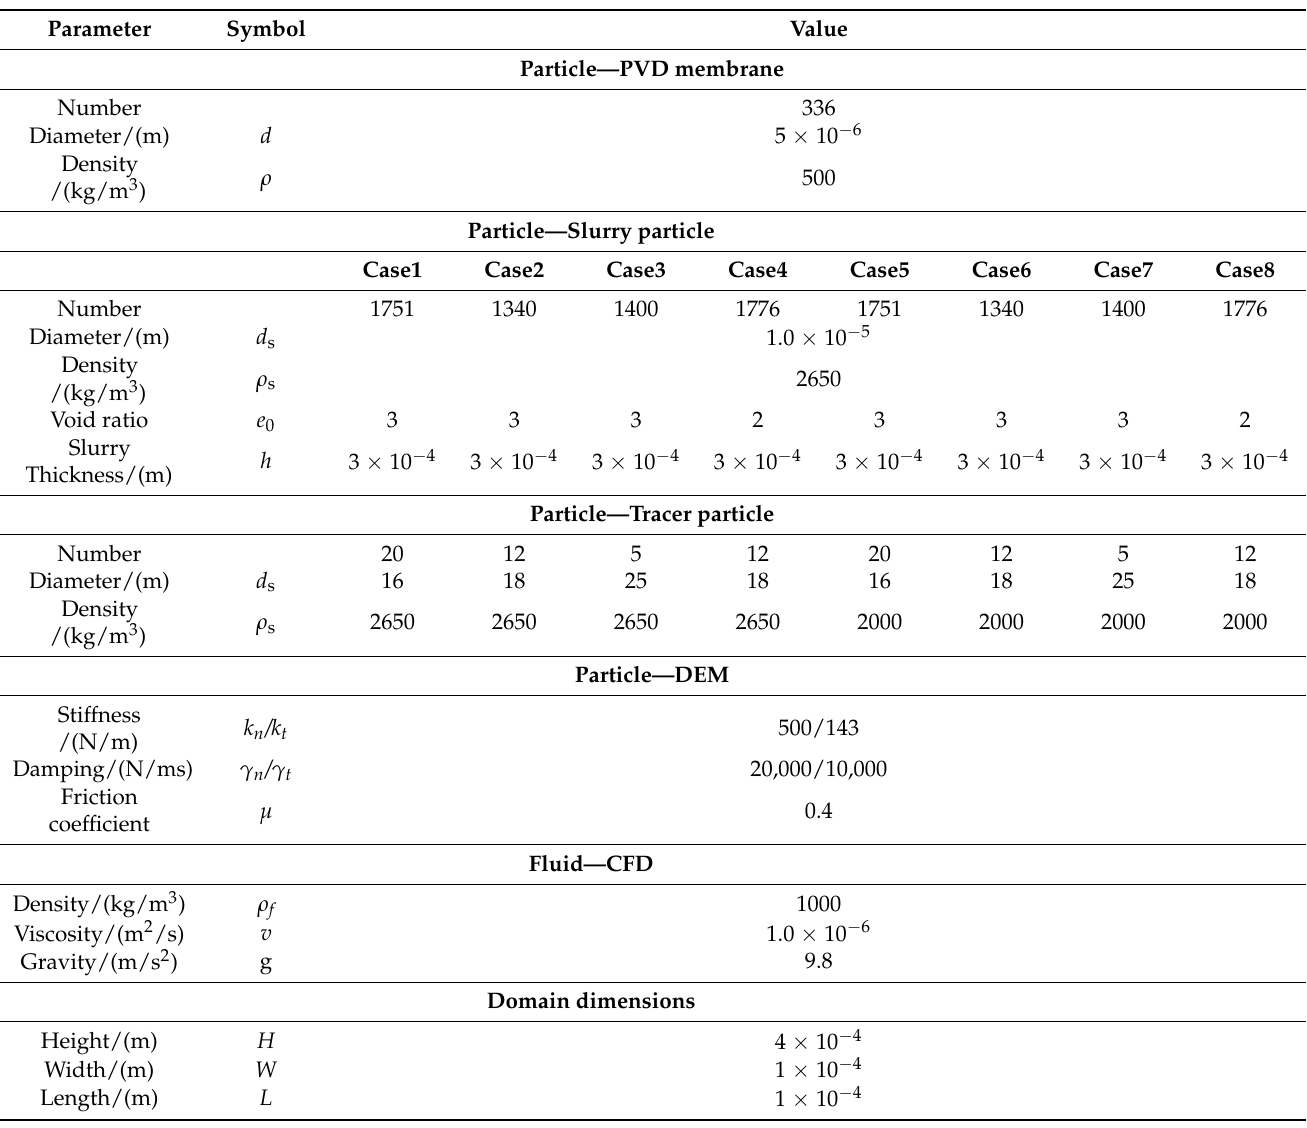
Table 4. Modeling cases and parameters of dredged slurry and PIV